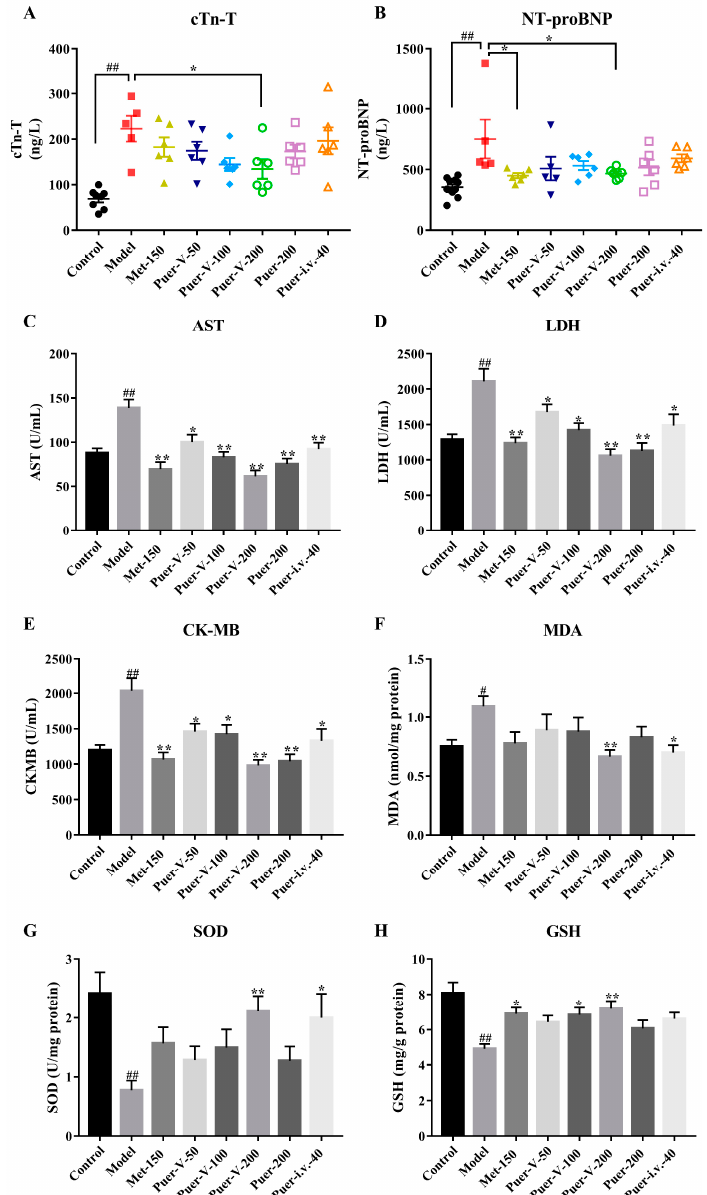
Figure 9. Puerarin-V improved necrosis and antioxidative status of DCM rats. ( A – E ) The serum levels of cTn-T, NT-proBNP, AST, LDH, and CK-MB. ( F – H ) The content of MDA, SOD, and GSH activity in the myocardium. The data are represented by mean ± SEM (n = 6–8). # p < 0.05 and ## p < 0.01 vs. control group. * p < 0.05 and ** p < 0.01 vs. model